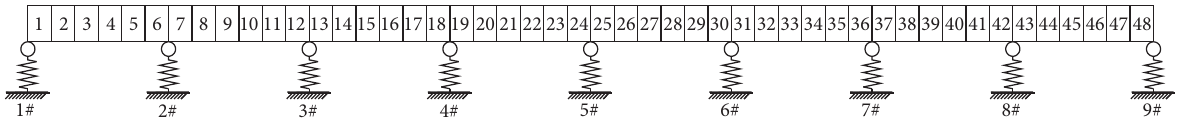
Figure 7: The 8-span continuous beam structure. Table 1: The damage cases of the continuous beam